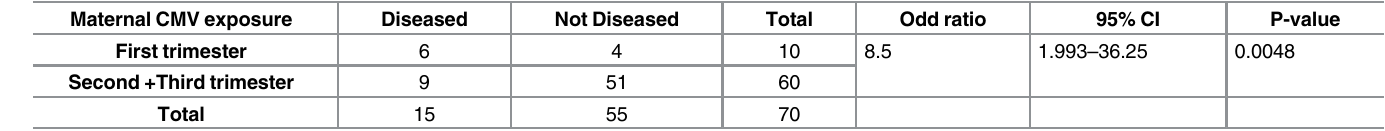
Table 4. Association of clinical infection in newborns compared to the mother ’ s gestational stage of CMV exposure.